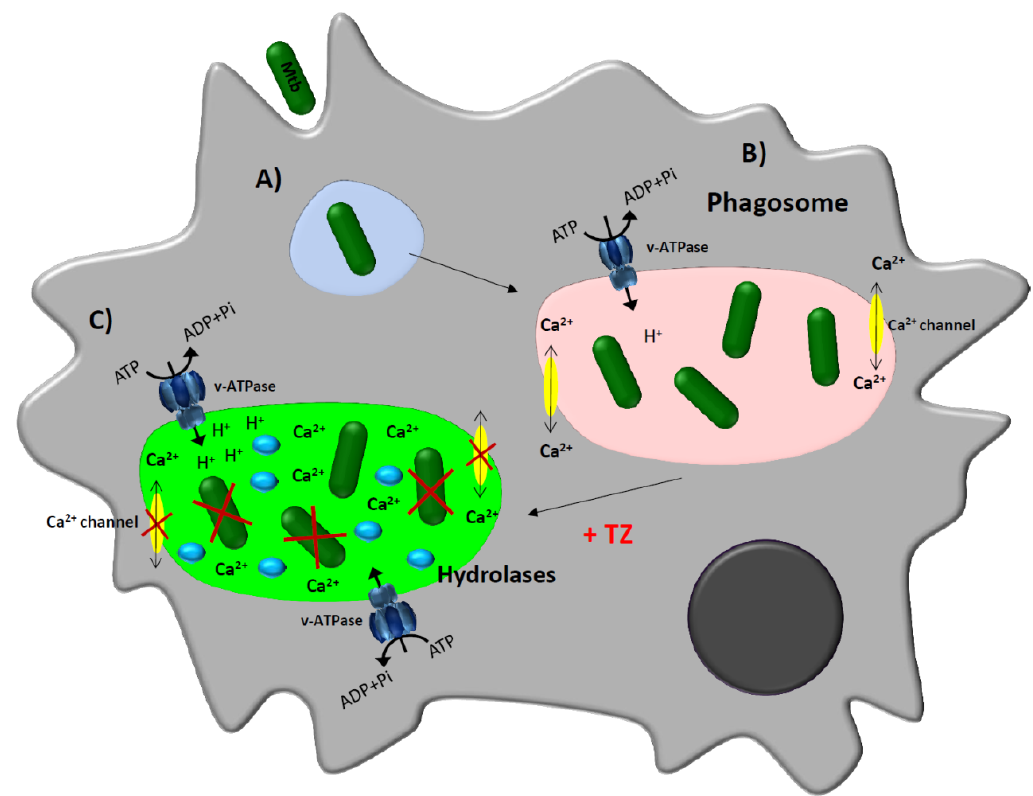
Figure 3. Schematic model proposed for the enhancement of the macrophage killing activity by thioridazine [26,50,62,69,71]. Infected macrophage. ( A ) The bacterium is recognized by receptors present on the plasma membrane of the macrophage and is internalized by invagination of the plasma membrane into a phagosome; ( B ) Once the phagosome is formed, the bacteria will manipulate the immune response, leading to the reduction of the availability of calcium within the phagosome, preventing the process of acidification needed for the activation of the hydrolases and the bacteria are thus not killed; ( C ) Treatment of infected-macrophages with Ca 2+ /ion channel blockers such as thioridazine (TZ) will increase the concentration of calcium into the cytoplasm and the transcription and activity of vacuolar proton (H+)-ATPases. This rise of protons causes the decrease of the pH in the phagolysosome, activating hydrolases that consequently kill the mycobacteria.